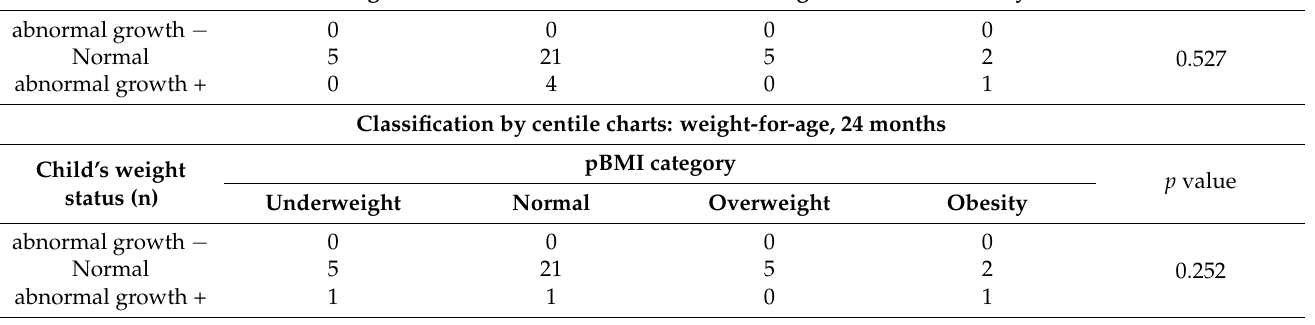
Classification by centile charts: BMI-for-age, 12 months